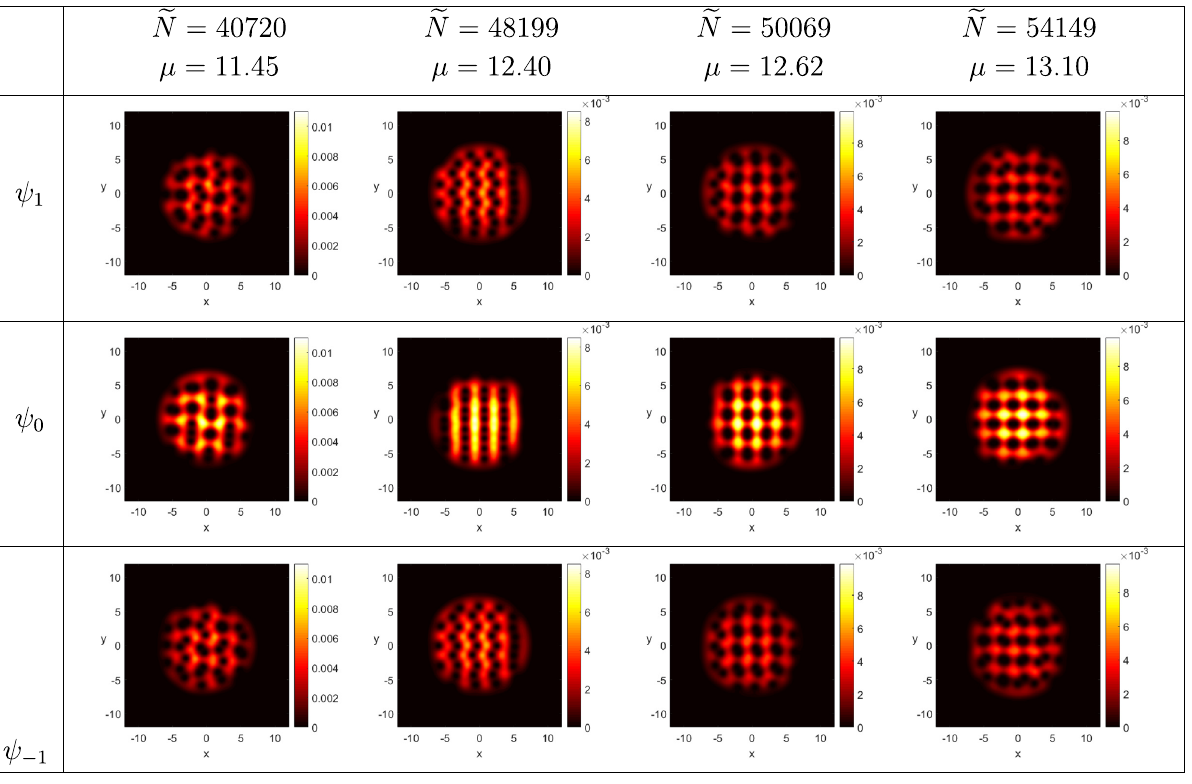
23 Na , where k 0